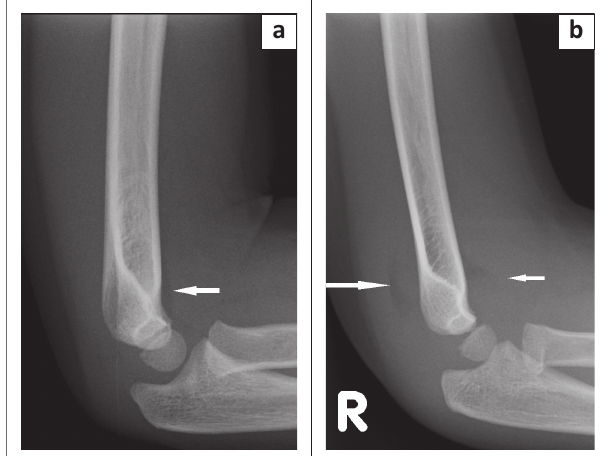
FIGURE 3: (a) Good quality lateral projection with the posterior supracondylar ridges superimposed and olecranon in profile. Note the normal anterior fat pad lying parallel to the anterior humeral shaft (arrow). (b) Lateral projection in patient with radial neck fracture showing a posterior fat pad (long arrow) and displaced anterior fat pad (short arrow).